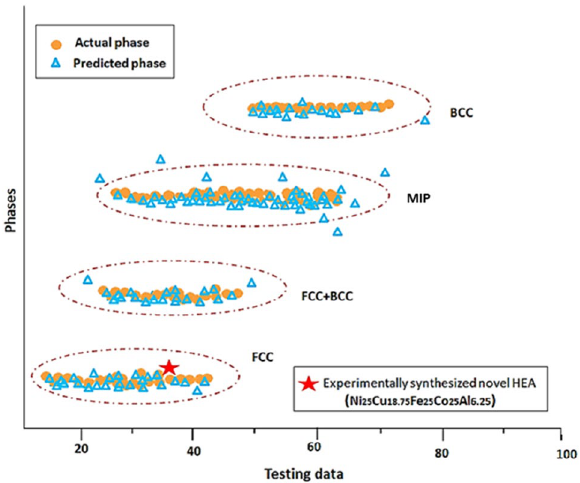
Figure 9. Phase prediction of novel HEA composition Ni 25 Cu 18.75 Fe 25 Co 25 Al 6.25 (shown in red asterisk), along with 240 test